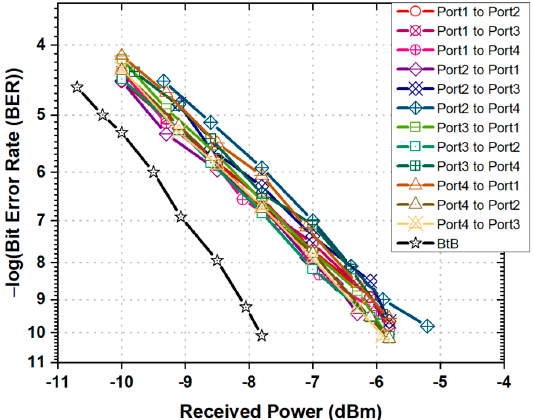
Figure 7. BER curves versus received power at 50 Gb/s for the links between ToRs.